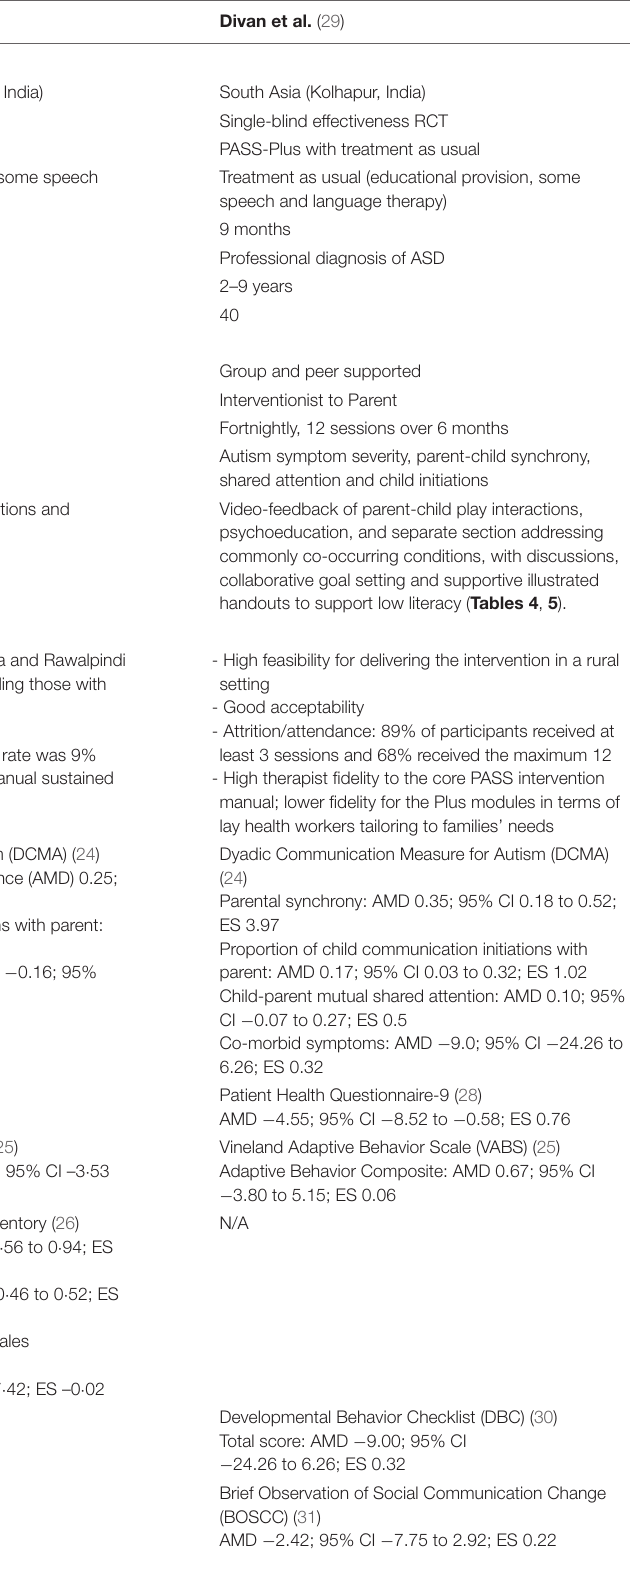
TABLE 3 | Key characteristics of studies identified by the scoping review. Rahman et al. (22) Divan et al.